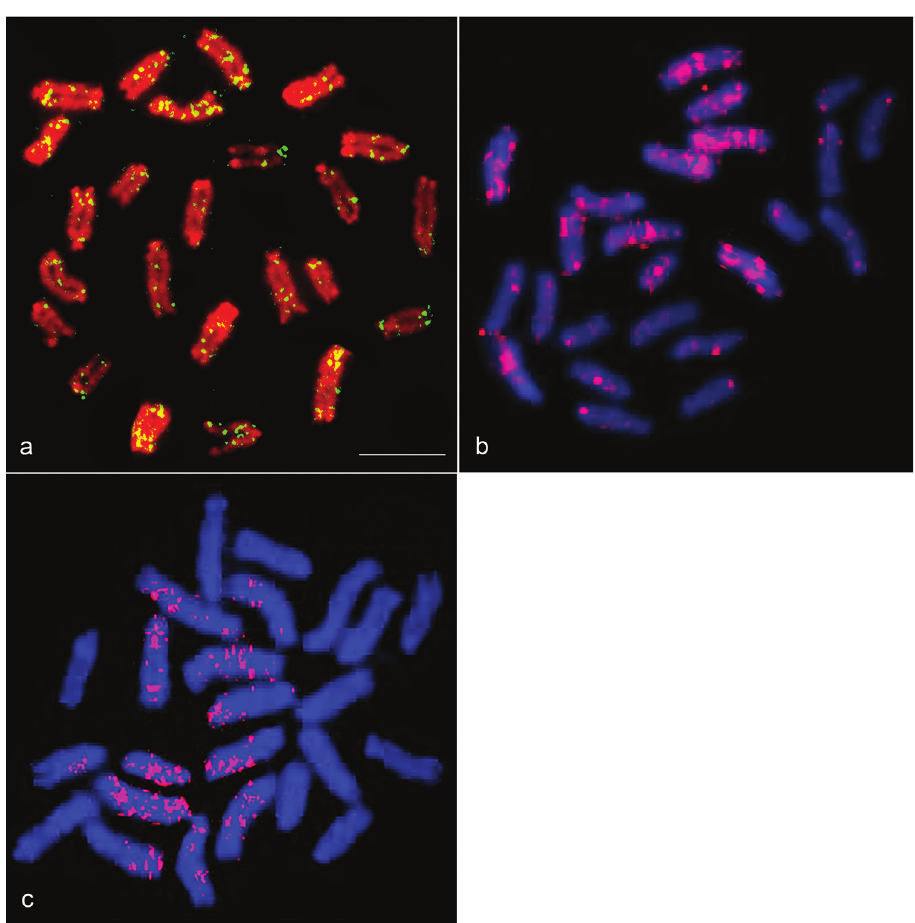
Figure 4. Chromosomal locations of Rex1 , Rex3 , and Rex6 in Monopterus albus . Hybridization pattern of FITC-labeled Rex1 (green) ( a ) on PI-stained chromosomes, and rhodamine-labeled Rex3 (red) ( b ) and Rex6 (red) ( c ) on DAPI-stained chromosomes. Scale =10